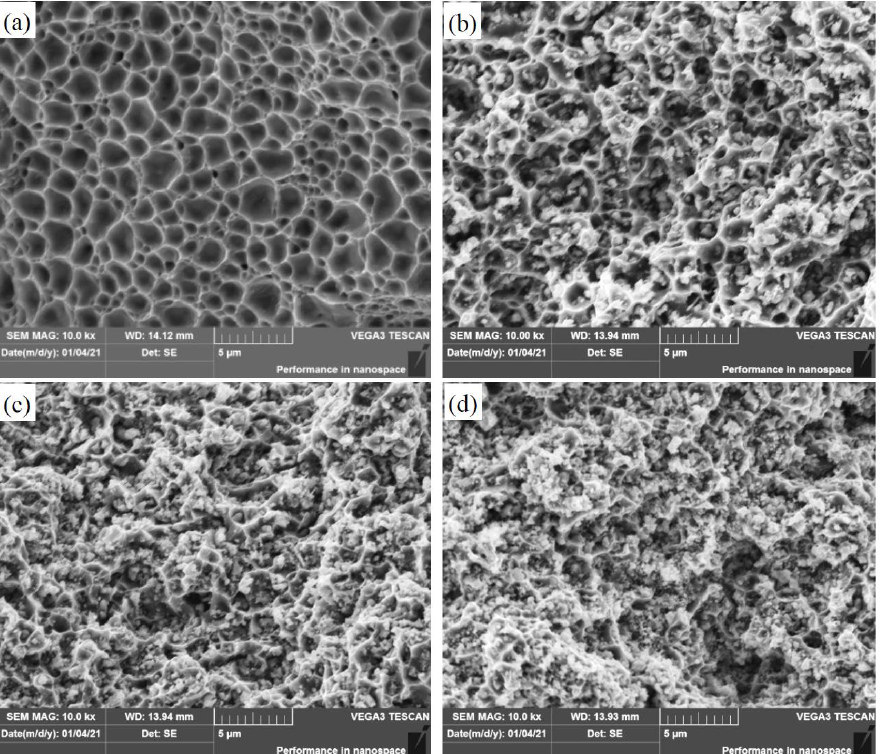
Figure 5. Fracture morphologies of Cu-W composites with different W contents: ( a ) Cu; ( b ) Cu-10 wt% W; ( c ) Cu-20 wt% W; ( d ) Cu-30 wt% W.